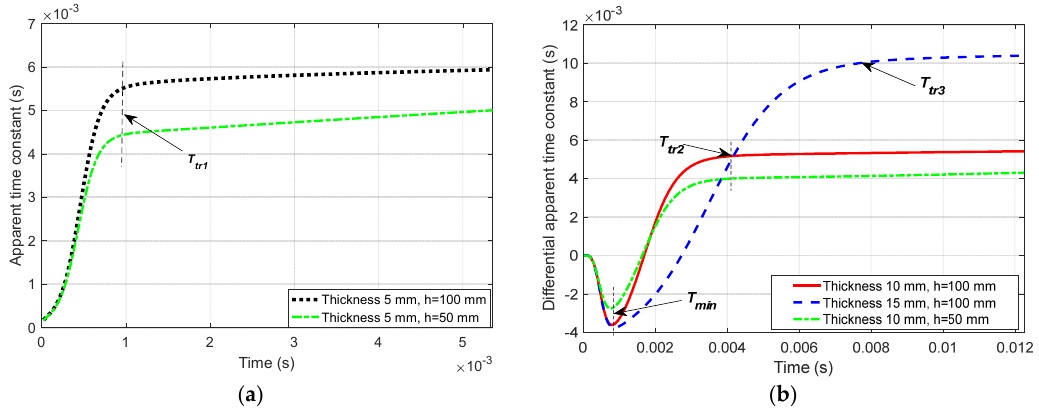
Figure 8. The effect of lift-off distance on pulsed eddy current detection signal. ( a ) The D-ATC curves corresponding to d = 5 mm aluminum plate with the lift-off of h = 100 mm and h = 50 mm, which have similar shapes and almost the same transient time. ( b ) Differential D-ATC curves of the 10 mm and 15 mm aluminum plates with the lift-off of h = 100 mm and h = 50 mm, lift-off variations did not change the transient time T tr 2 and the time to minimum T min Still taking the D-ATC curve of (ℎ, 𝑑) = (100, 5) mm model as the reference, the D- ATC curves of the 10 mm and 15 mm aluminum plates at the same life-off are compared with it to get the differential D-ATC curve, as shown by the red solid line and blue dashed line in Figure 8b. It can be seen that the transient time 𝑇 (cid:3047)(cid:3045)(cid:2870) and 𝑇 (cid:3047)(cid:3045)(cid:2871) of the differential D- ATC curves are consistent with that of the corresponding D-ATC curve shown in Figure 4, and the time to minimum 𝑇 (cid:3040)(cid:3036)(cid:3041) of the differential D-ATC curves is slightly ahead of the transient time of the reference D-ATC curve.